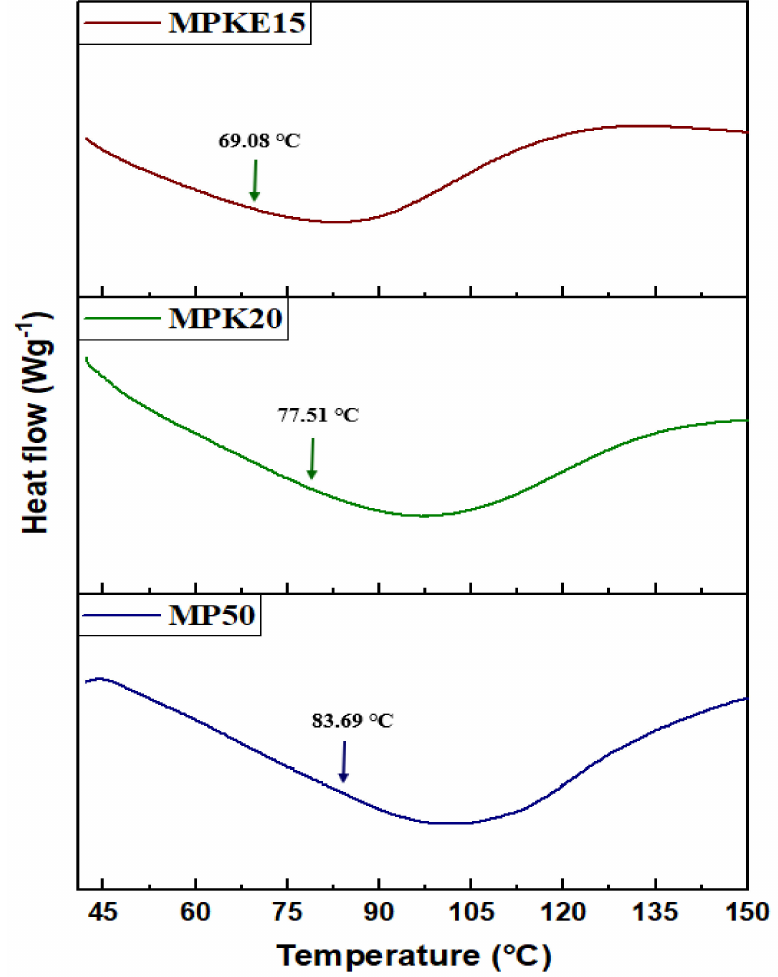
Figure 8. DSC thermograms of selected MC/PVP-based